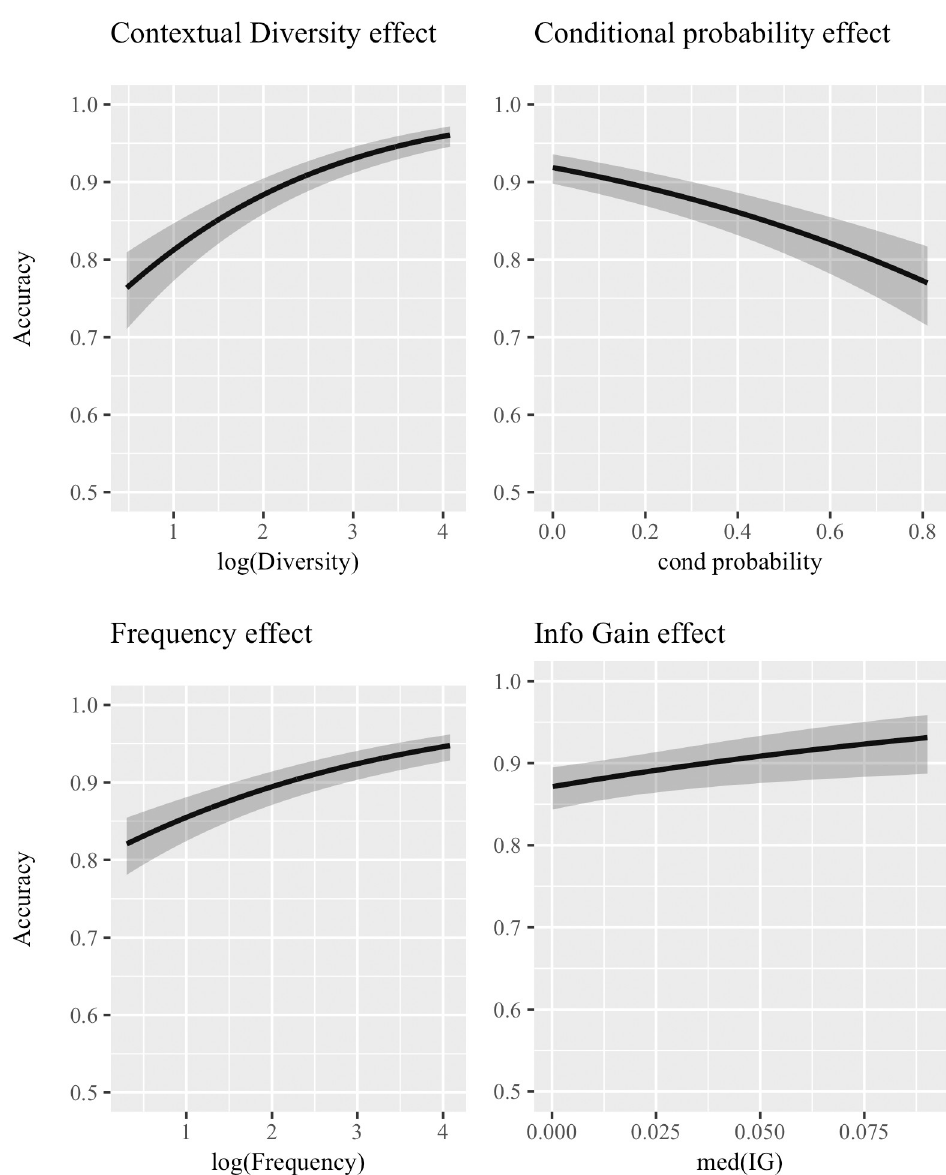
Fig 1. Logistic mixed-effect models for single predictors—Cosine distance. Effects of the logistic mixed-effect models which included a single predictor (inputted in the model together with Time, which is part of the baseline model) using categorization accuracy achieved with cosine as distance metric as the dependent variable. Subplots are ordered according to the reduction in AIC caused by adding the predictor to the baseline model: the most important predictor is in the top-left panel, then top-right, bottom-left, and finally bottom-right. 95% confidence bands are shown.